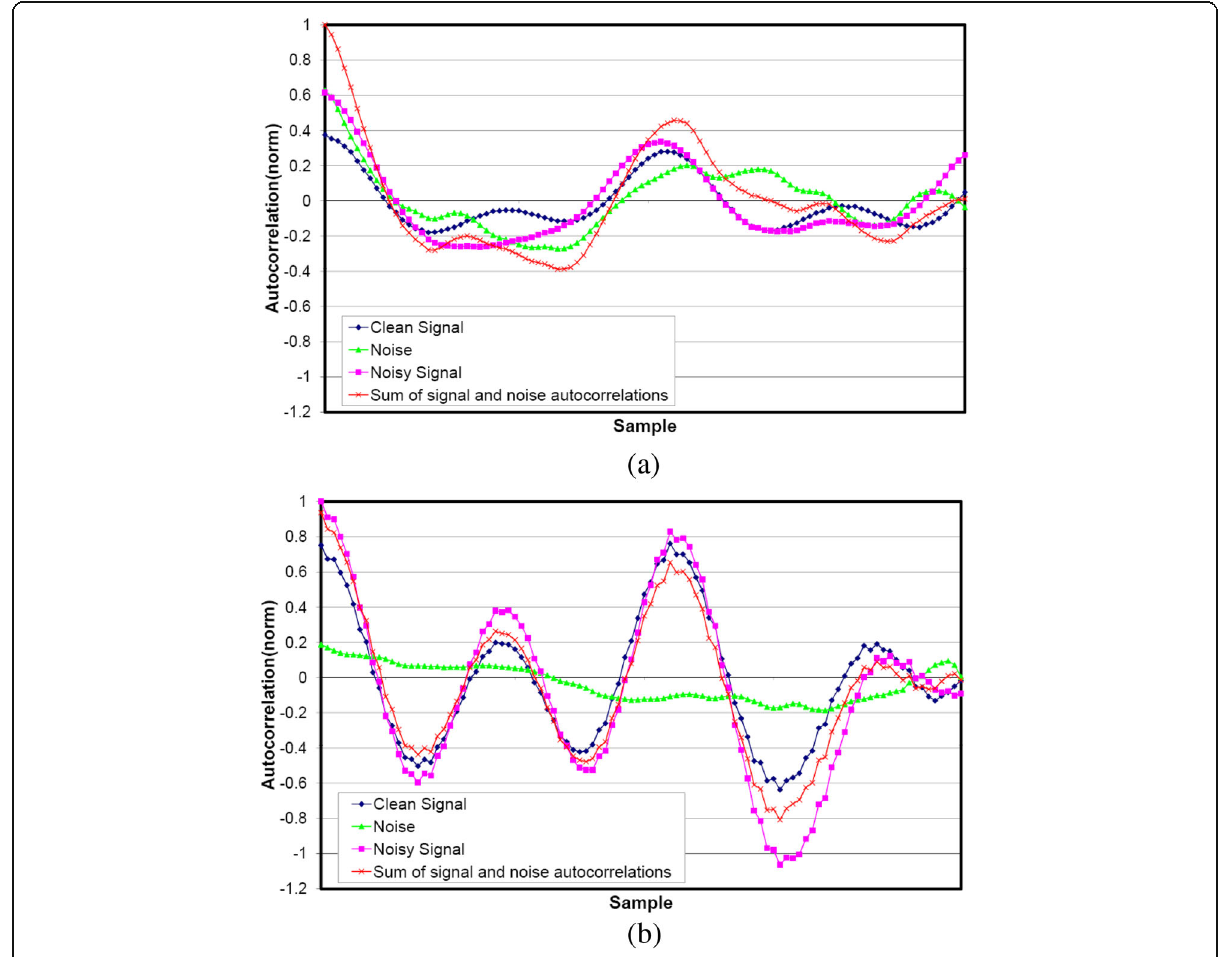
Fig. 3 Sample autocorrelation sequences of the clean speech, noisy speech, and noise as well as sum of the autocorrelations of clean speech signal and noise with a babble noise and b factory noise, with an SNR of 10